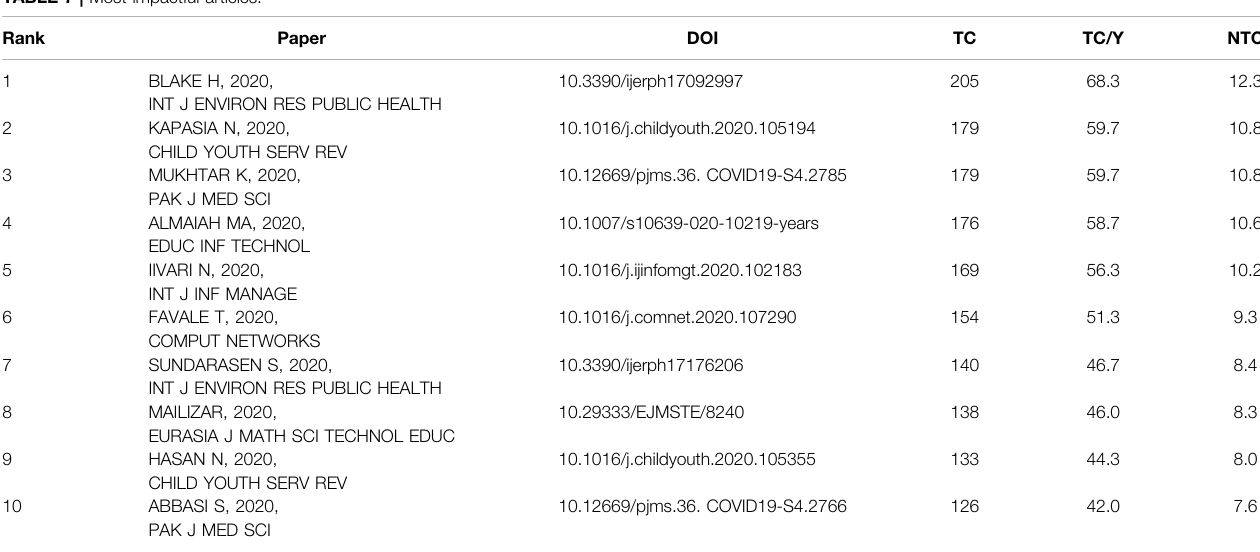
TABLE 7 | Most impactful articles.